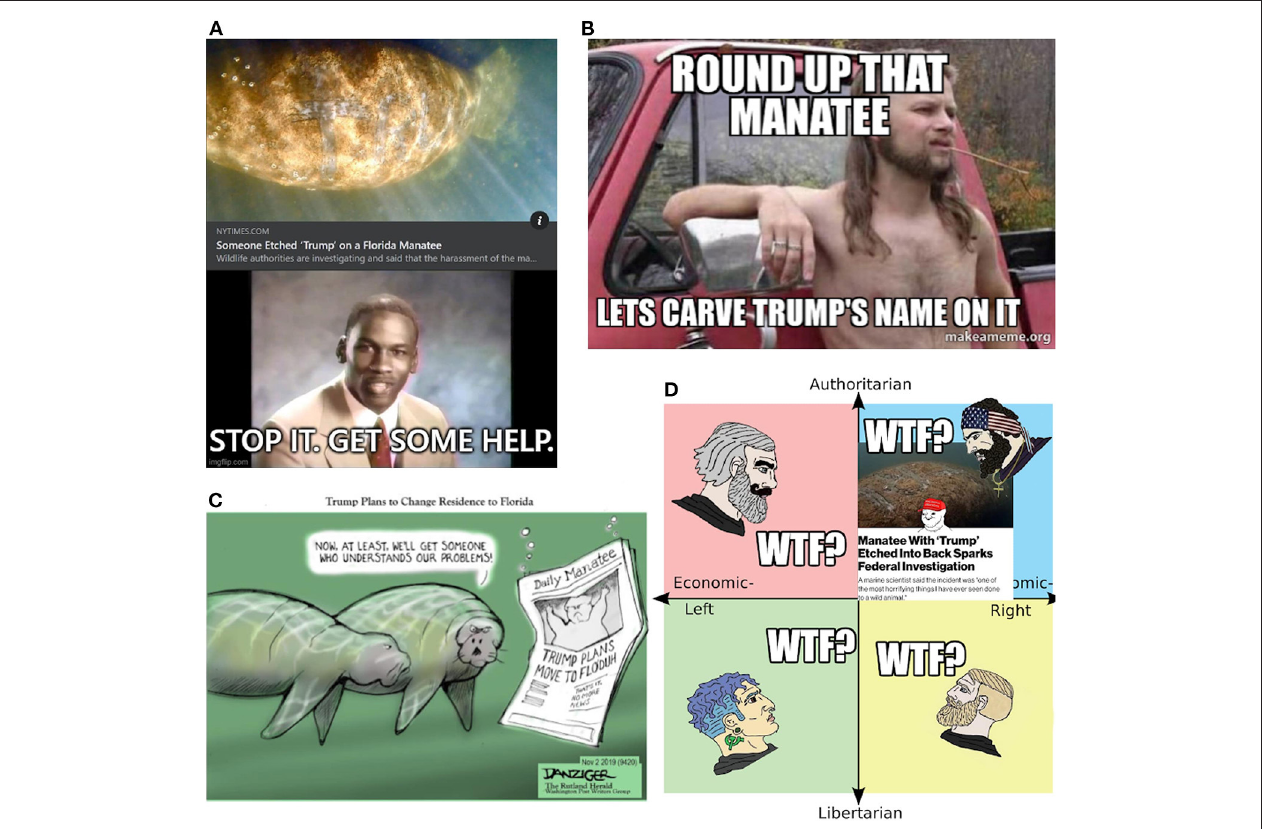
FIGURE 10 | The remixes of the Trump manatee. (A) Michael Jordan meme screen capture from imgflip.com. (B) The Florida Man screen capture from makeameme.org. (C) A political cartoon screen capture from VTDigger.org. (D) A depiction of unity across political parties over the Trump manatee screen capture from the Reddit thread